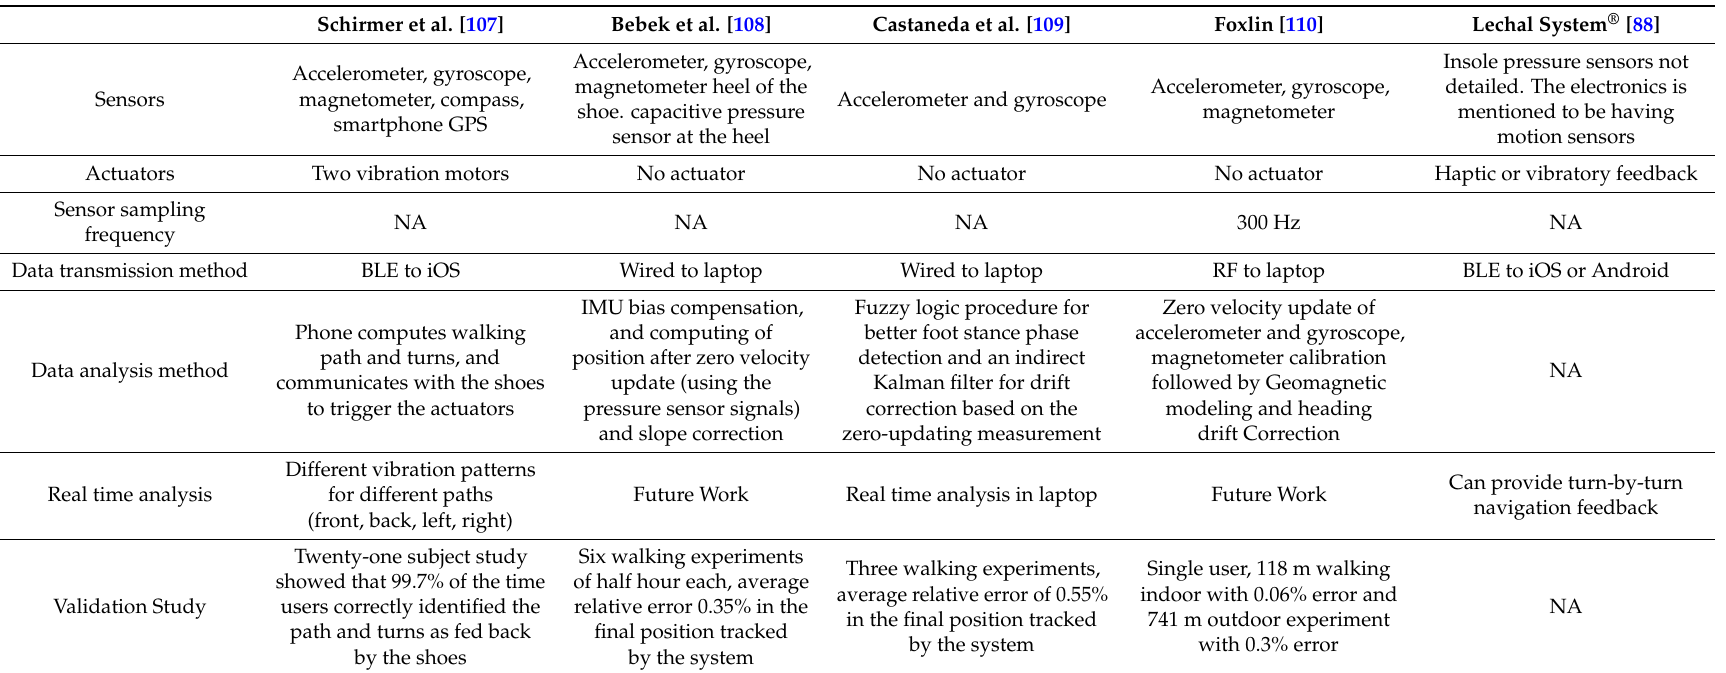
Table 6. Comparison of footwear-based navigation